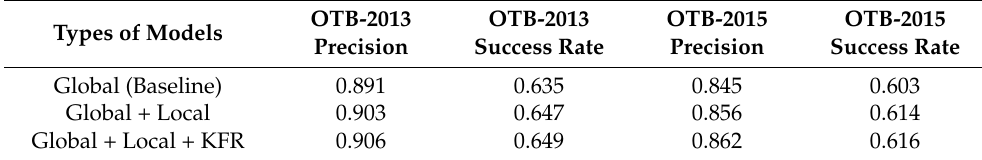
Table 2. Effectiveness study of proposed local–global cooperation mechanism and KFR.